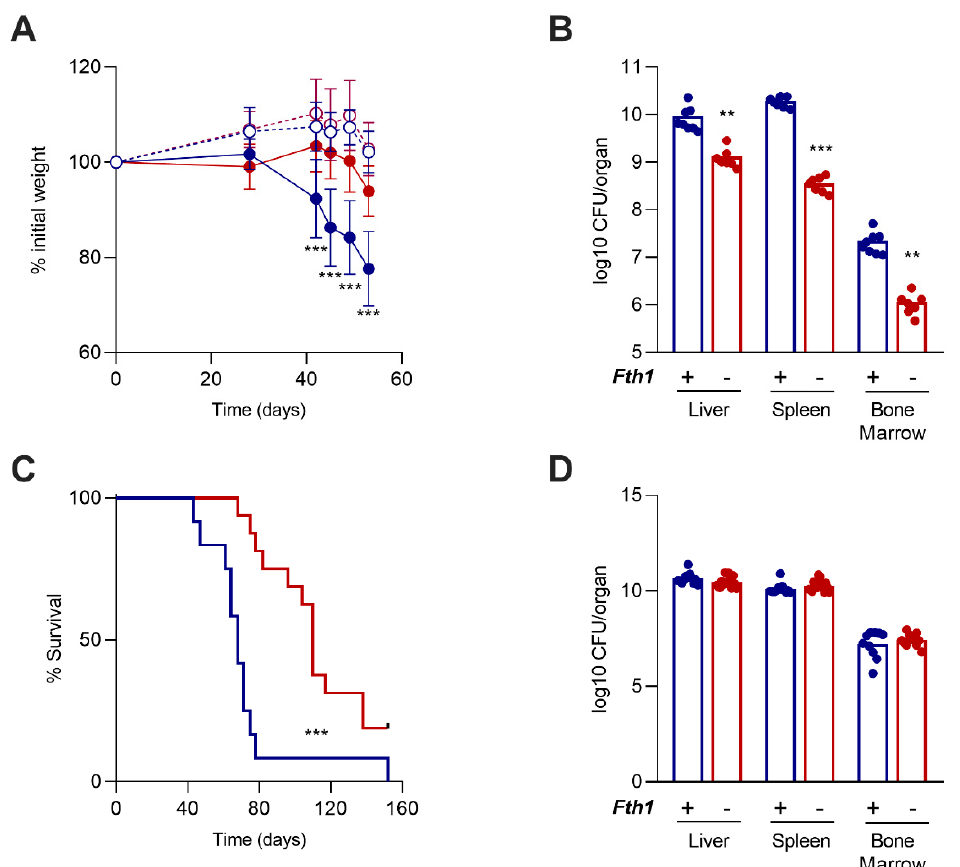
Figure 1. Evolution of infection by Mycobacterium avium in mice deficient in H-ferritin in myeloid cells. Fth1 +/+ (blue) and Fth1 − / − (red) mice were intravenously infected with 10 6 CFU of M. avium 25291. ( A ) Animals’ body weight throughout the experiment. Data are expressed as percentage of the initial weight, presented as the mean ± SD of 5 to 8 animals per group. Empty circles: noninfected; filled circles: infected. ( B ) Bacterial burden 60 days post-infection in the liver, spleen, and bone marrow of 8 Fth1 +/+ and 7 Fth1 − / − mice. Bars represent the mean, and circles represent each animal. ( C ) Kaplan–Meier survival curve corresponding to 12 Fth1 +/+ and 16 Fth1 − / − animals. Mice were euthanized when they lost 20% of the initial weight (between day 43 and day 152 post infection). ( D ) Bacterial burden in the liver, spleen, and bone marrow, at the time of euthanasia in the survival curve, of 12 Fth1 +/+ and 16 Fth1 − / − mice. Bars represent the mean and circles represent each animal. Statistics: multiple t -test in ( A , B , D ); log-rank (Mantel–Cox) test in ( C ). ** p < 0.01 and *** p < 0.001 when comparing Fth1 − / − with Fth1 +/+ mice.